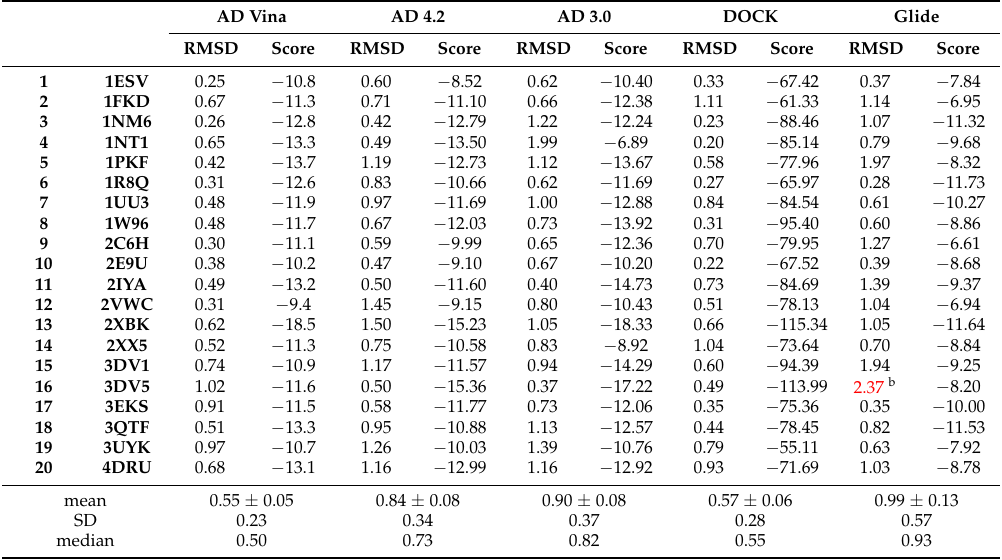
Table 1. RMSD values (in Å) and scoring energies a for the self-docking of each ligand in its binding